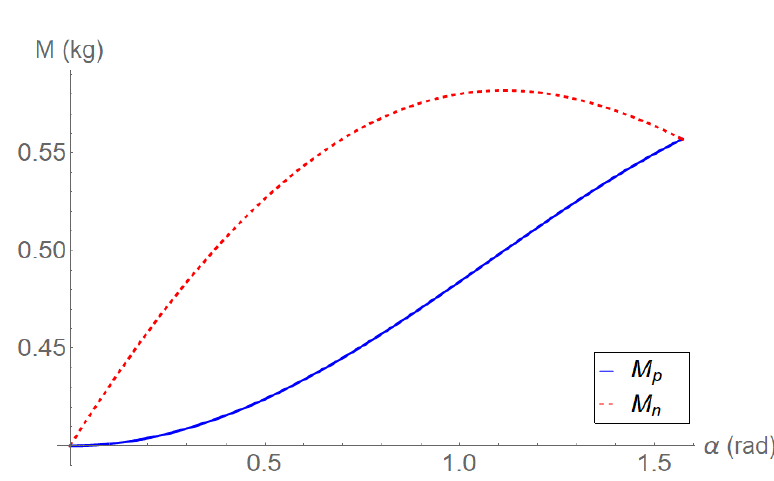
Figure 8. The asymmetric total mass of the swimmer versus the fin angle α for forward motion ( M p ) and backward motion ( M n ).